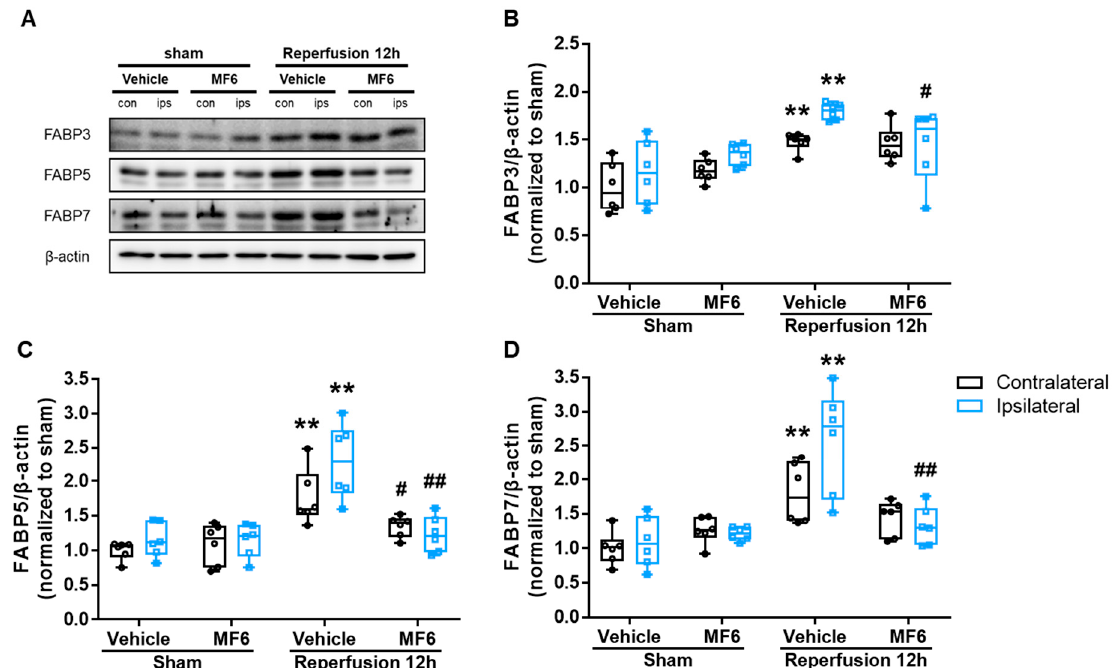
Figure 6. Effects of MF6 administration on FABP3, FABP5 and FABP7 expression levels in I/R mice. Mice were subjected to right tMCAO for 2 h and administered 3 mg/kg MF6 at 30 min after reperfusion. At 12 h after reperfusion, the second slice of the right (ipsilateral) and left (contralateral) brain areas, including the cortex and striatum, were used for Western blot analysis of FABP levels. ( A ) Representative images of Western blots. Quantitative analyses of FABP3 ( B ), FABP5 ( C ) and FABP7 ( D ) proteins expression levels in the contralateral (black) and ipsilateral (blue) regions of the brains. ** p < 0.01 vs. the sham-treated group, administered the vehicle (contralateral/ipsilateral); # p < 0.05, ## p < 0.01 vs. the I/R-treated group, administered the vehicle (contralateral/ipsilateral) (n = 6 per group). Differences were statistically analyzed using two-way analysis of variance (ANOVA) followed by Student–Newman–Keuls test.